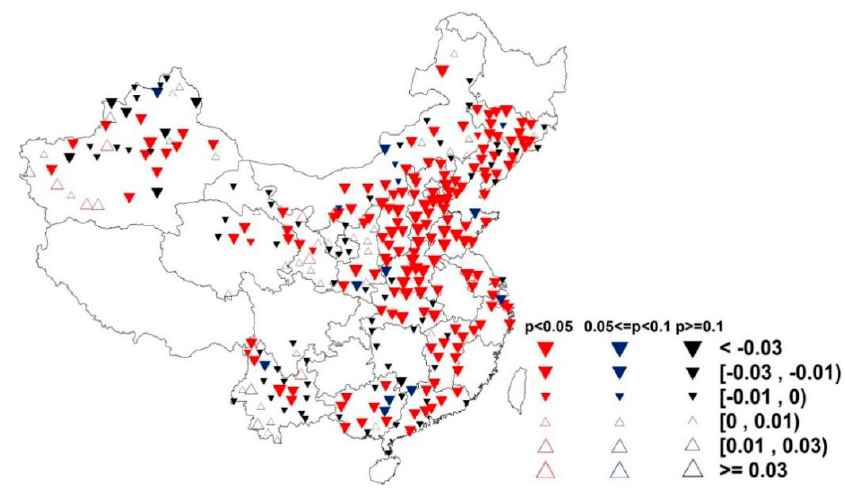
Figure 6. Spatial patterns of changes in sunshine duration (SD) during 1962–2011 (h / year) at 360 observational stations in China. The color of the circles indicates the significance level of change. Solid or hollow triangles indicate the magnitude of change. Maps in this figure were created by ArcGIS 9.3 (ESRI, 2008).